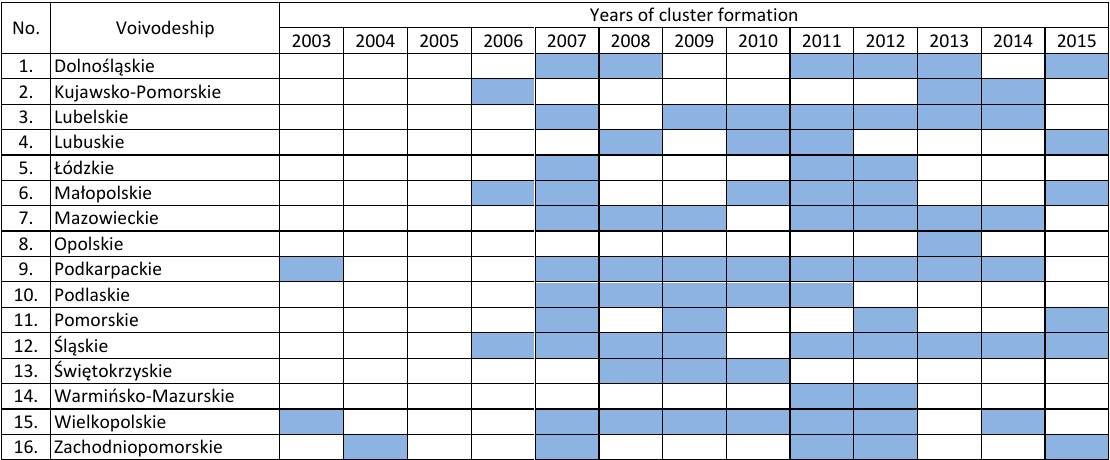
Table 1: The formation of clusters taking into account the criteria of the region and time (PARP, 2016)